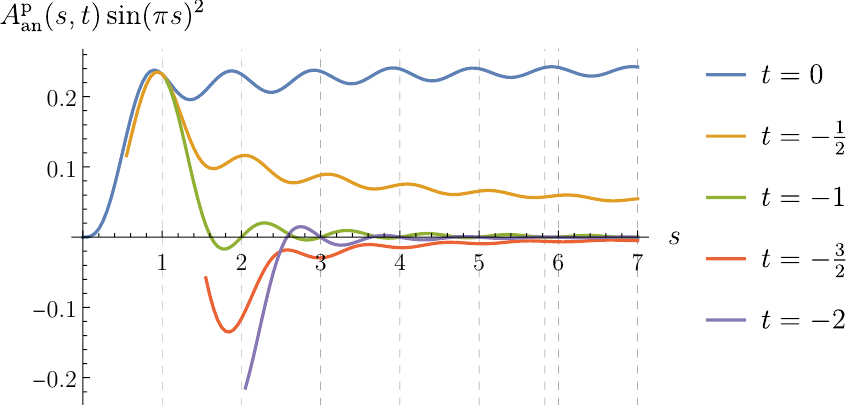
( s , t ) for few momentum transfers t in the s -channel, s > − t . Figure 25: Plot of Im A p an We multiply the function by sin ( π s ) 2 in order to remove double poles at every positive integer s . Dashed vertical lines indicate the values of s at which a new threshold opens